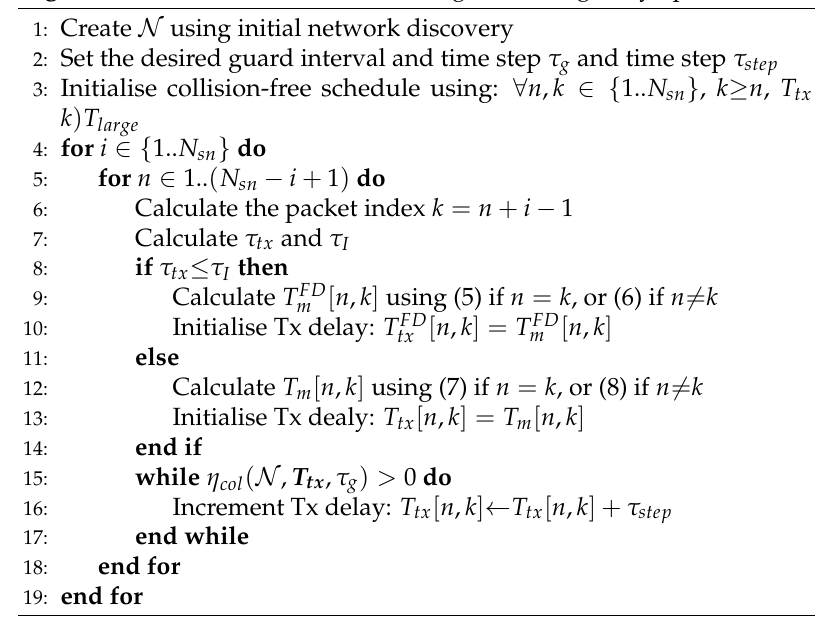
Algorithm 1 FD-LTDA-MAC scheduling based on greedy optimisation